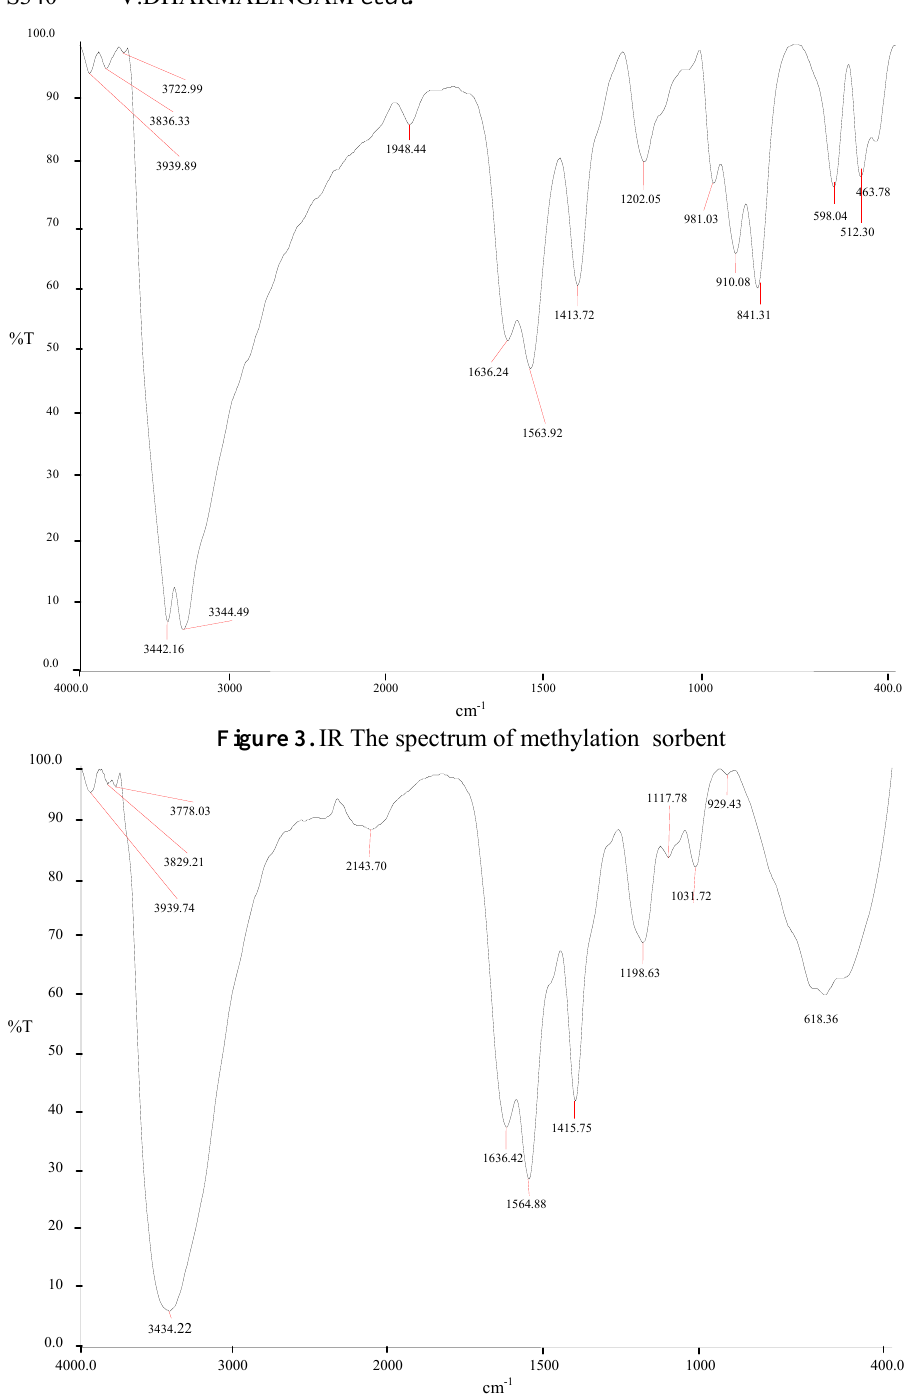
Figure 3. IR The spectrum of methylation sorbent